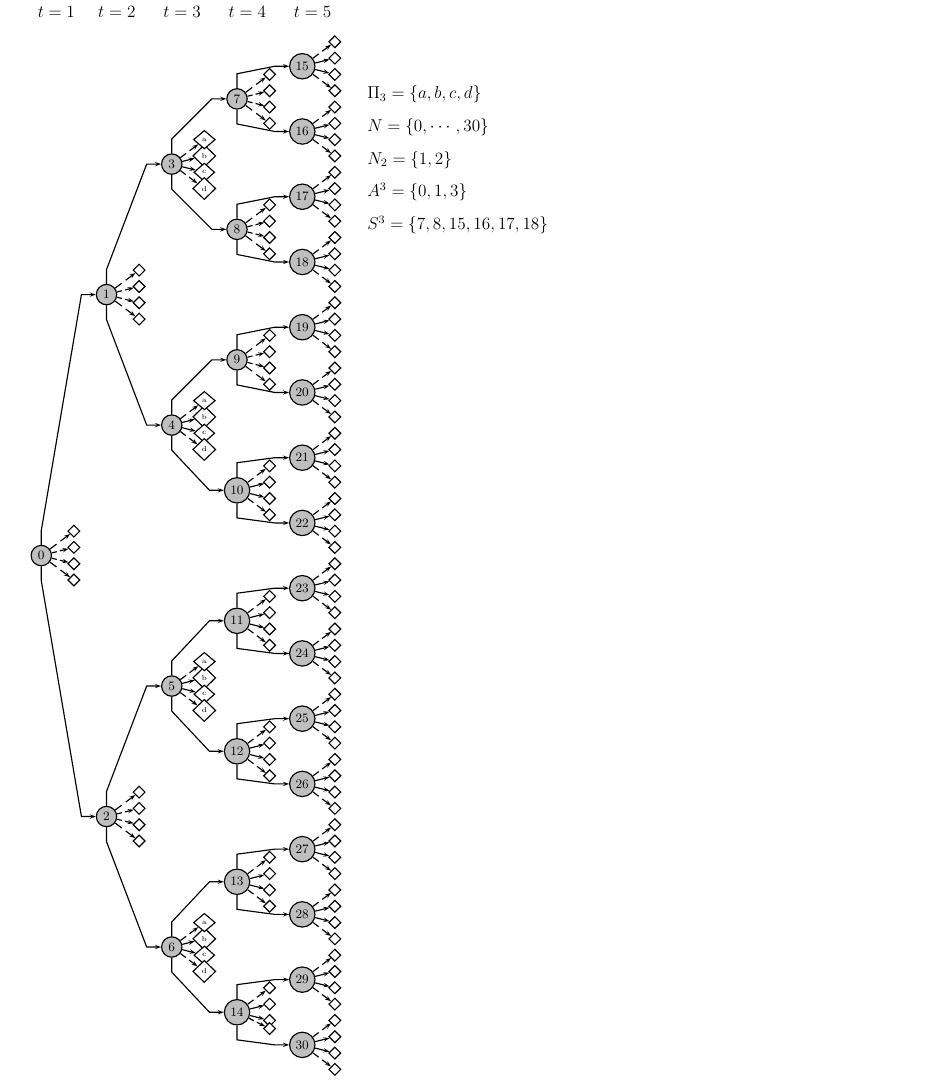
Figure 3. Strategic multistage scenario tree with operational two-stage scenario trees Location-Allocation Parameters for Strategic and Operational